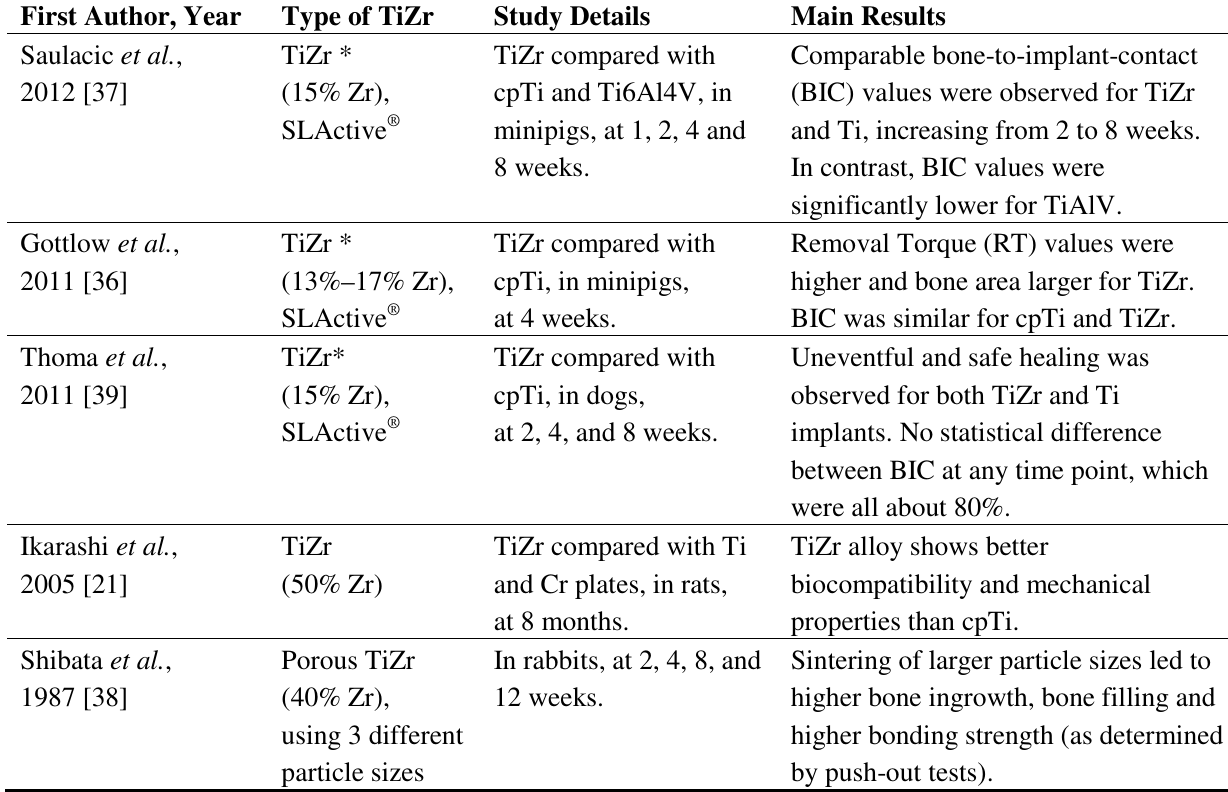
Table 2. Animal studies of TiZr dental implants.